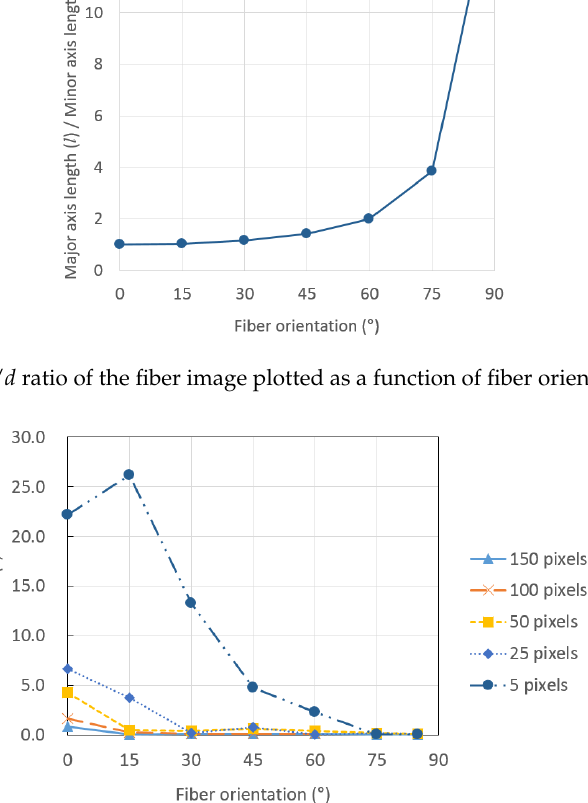
Figure 2. l / d ratio of the fiber image plotted as a function of fiber orientation, θ . Table 2. Measured orientation of the artificial fiber image according to the number of pixels in the diameter.